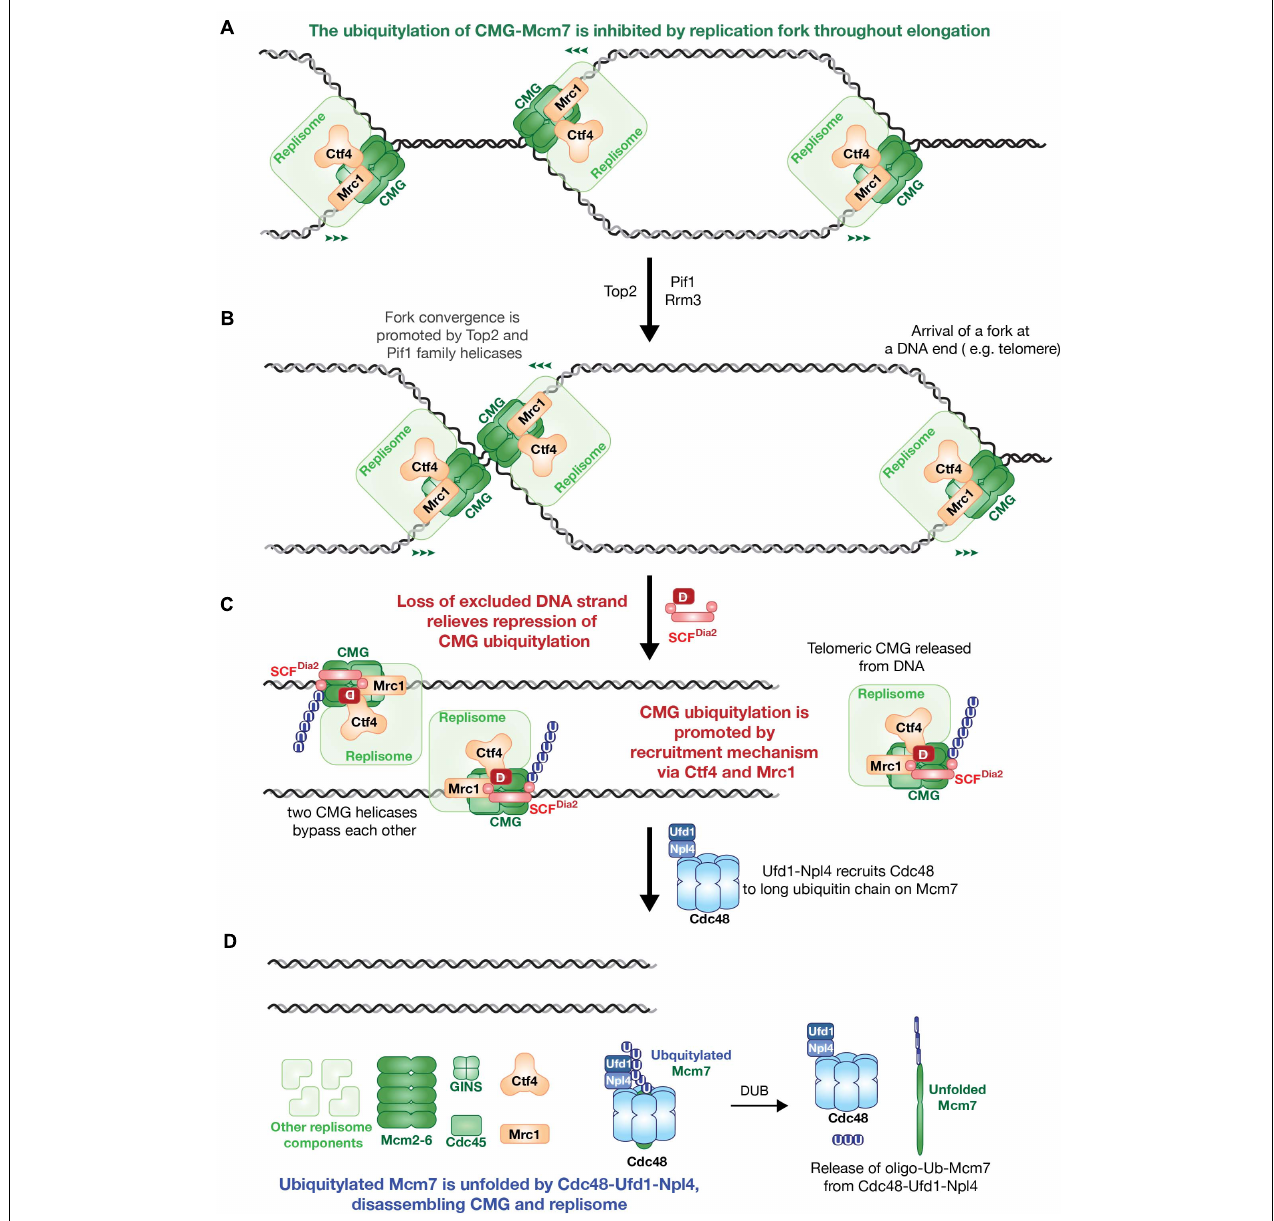
FIGURE 1 | The model of Saccharomyces cerevisiae replisome disassembly during DNA replication termination. (A) CMG ubiquitylation is inhibited by replication fork during replication elongation. (B) Fork convergence is promoted by type II topoisomerases and Pif1 family helicases. (C) Loss of excluded strand relieves repression of CMG ubiquitylation, then SCF Dia2 dependent Mcm7 ubiquitylation is promoted by recruitment mechanism via replisome components Ctf4 and Mrc1. (D) Ufd1-Npl4 recruits Cdc48 to ubiquitylated CMG to unfold poly-ubiquitylated Mcm7 subunit and disassemble